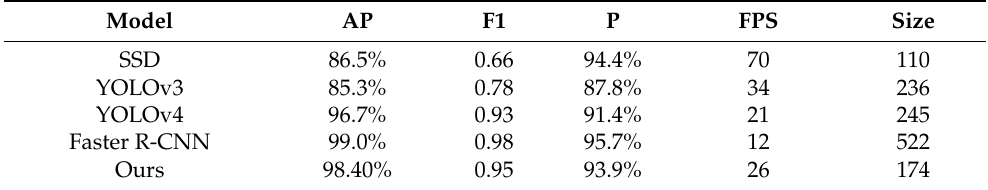
Table 5. Performance comparison of different models (three-segment